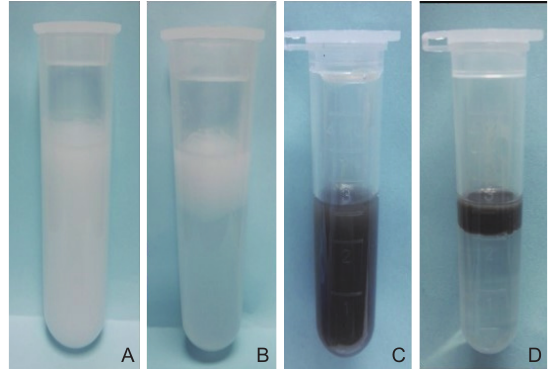
Figure 3 The photos of aqueous PLA microbubbles before (A) and after (B) standing for 30 minutes. The photos of aqueous PLA@GO microbubbles before (C) and after (D) standing for 30